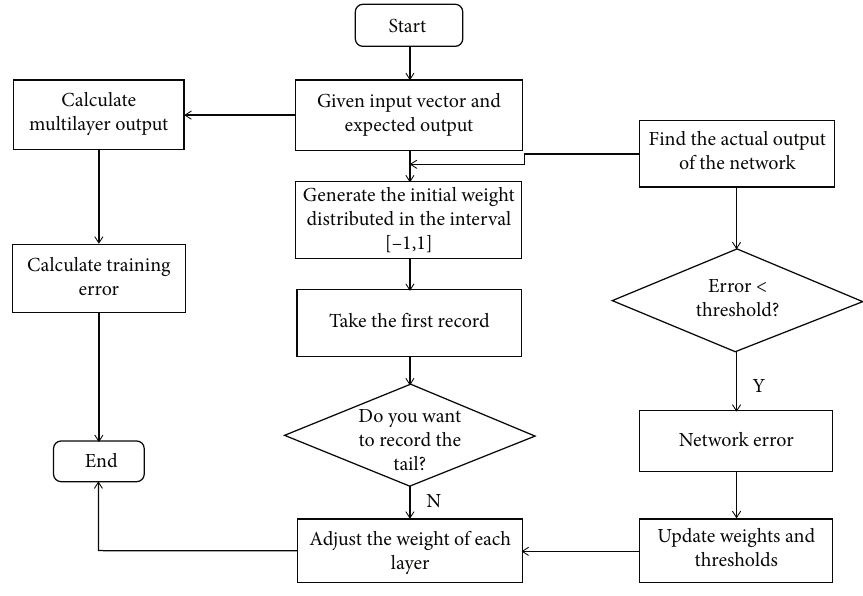
Figure 1: Flow chart of NNS